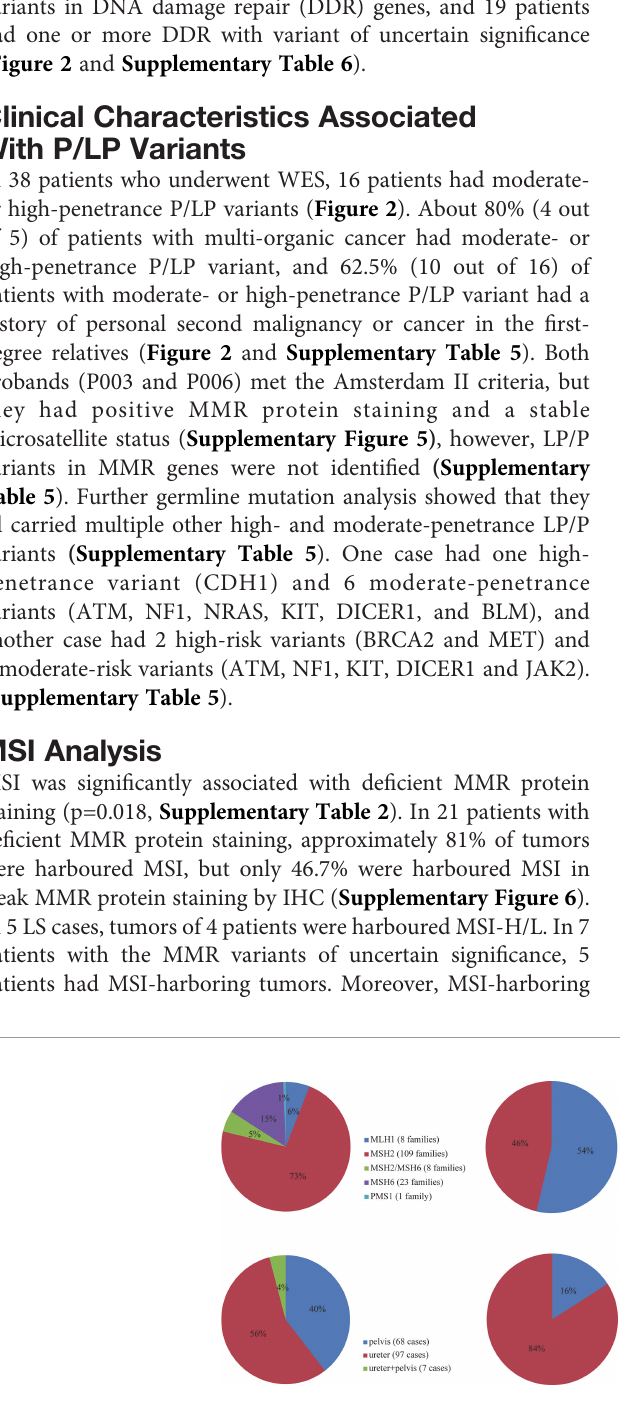
FIGURE 3 | The germline variants distribution and clinicopathological features of LS-UTUC by literature